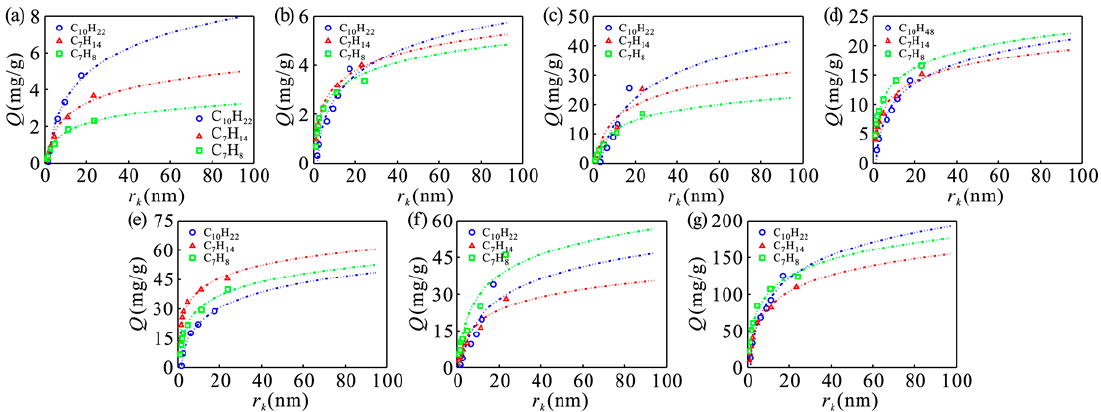
Figure 7. Relationship between radius of capillary condensation ( r k ) and the tested amounts ( Q ) of C 10 H 22 , C 7 H 14 and C 7 H 8 ( a – g : cookeite, ripidolite, kaolinite, illite, illite/smectite mixed-layer, Na-montmorillonite and Ca-montmorillonite).